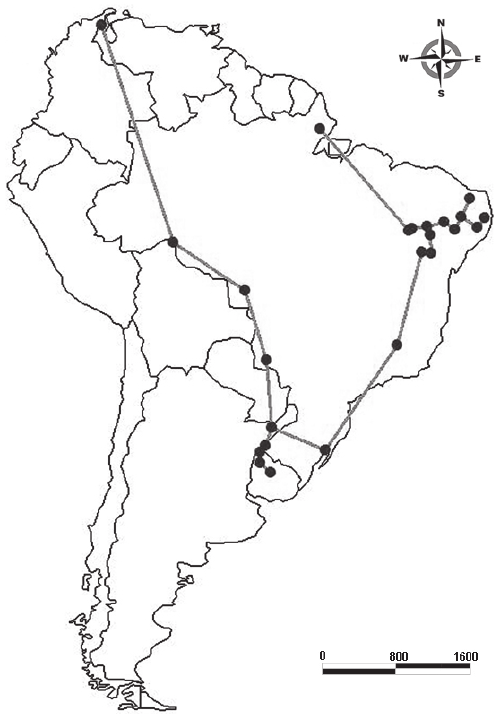
Fig. 17 - Individual track of Pampatherium humboldti .